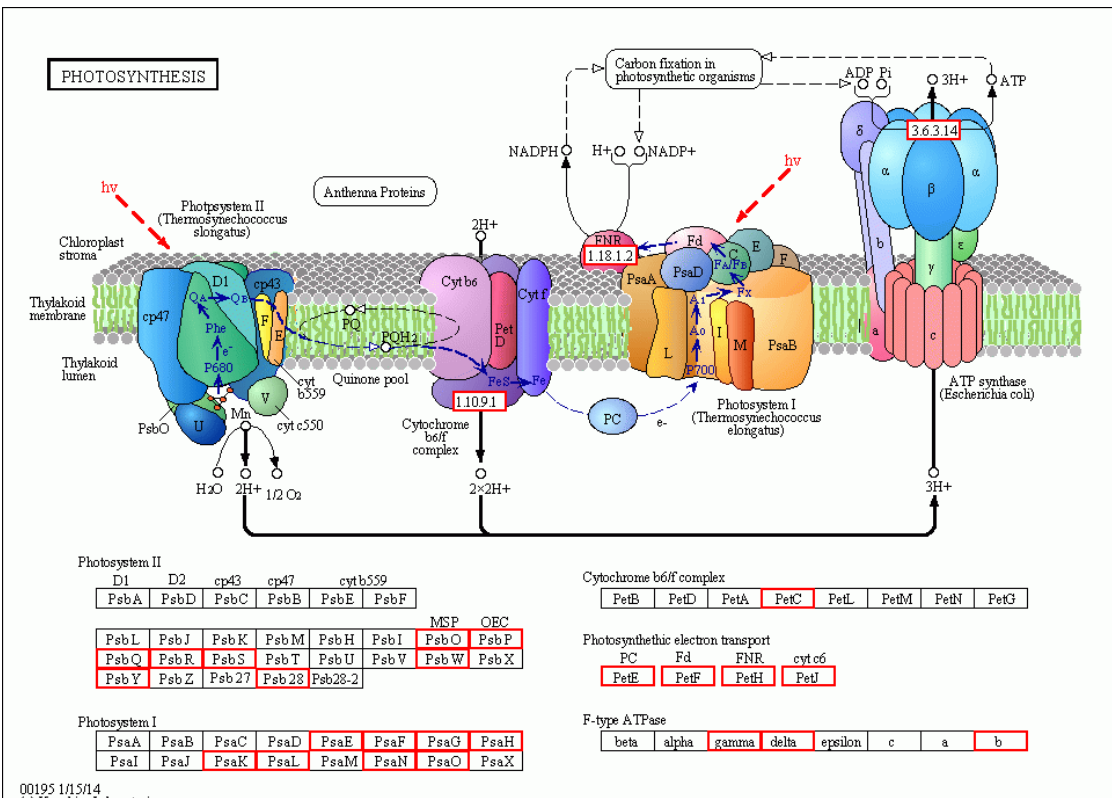
Figure 11. Diagram of the metabolic pathway of photosynthesis in CK-vs-LN. Red indicates related genes up-regulated in LN treatment.